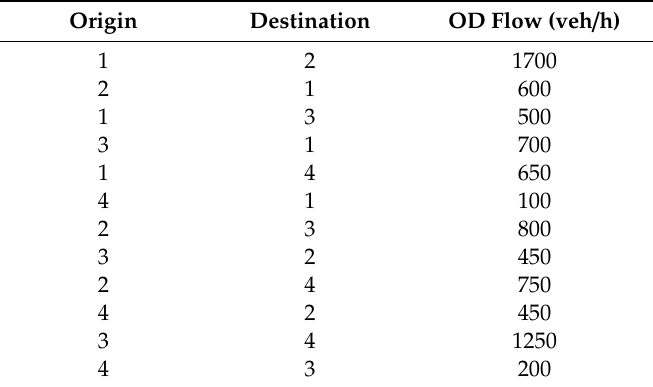
Table 2. Origin-destination vector of the small network.